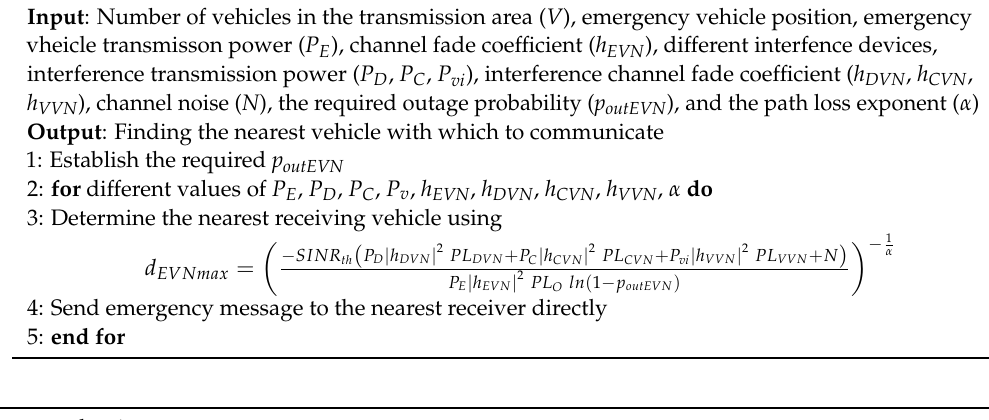
Algorithm 2 : System performance